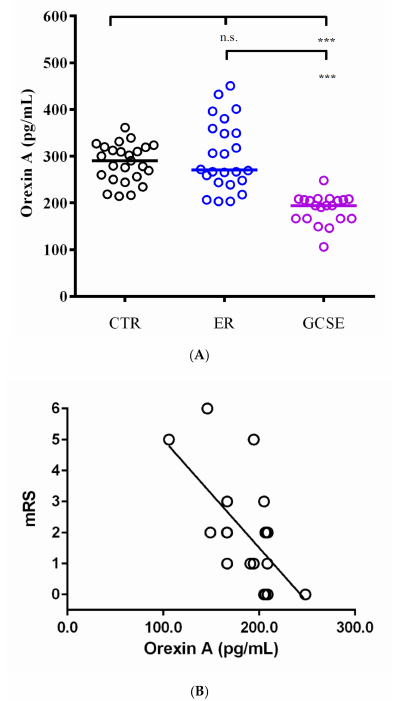
Figure 1. ( A ) Cerebrospinal fluid (CSF) orexin-A levels (pg / mL) in controls (CTR), epilepsy patients in remission (ER), and patients with generalized convulsive status epilepticus (GCSE) (GCSE vs. CTR, p < 0.001; GCSE vs. ER, p < 0.001; ER vs. CRT, p > 0.05); *** p < 0.001; n.s. = not significant. ( B ) Cerebrospinal fluid (CSF) orexin-A levels (pg / mL) correlated with modified Rankin Score (mRS) in patients with GCSE (Spearman, r = − 0.55; p =